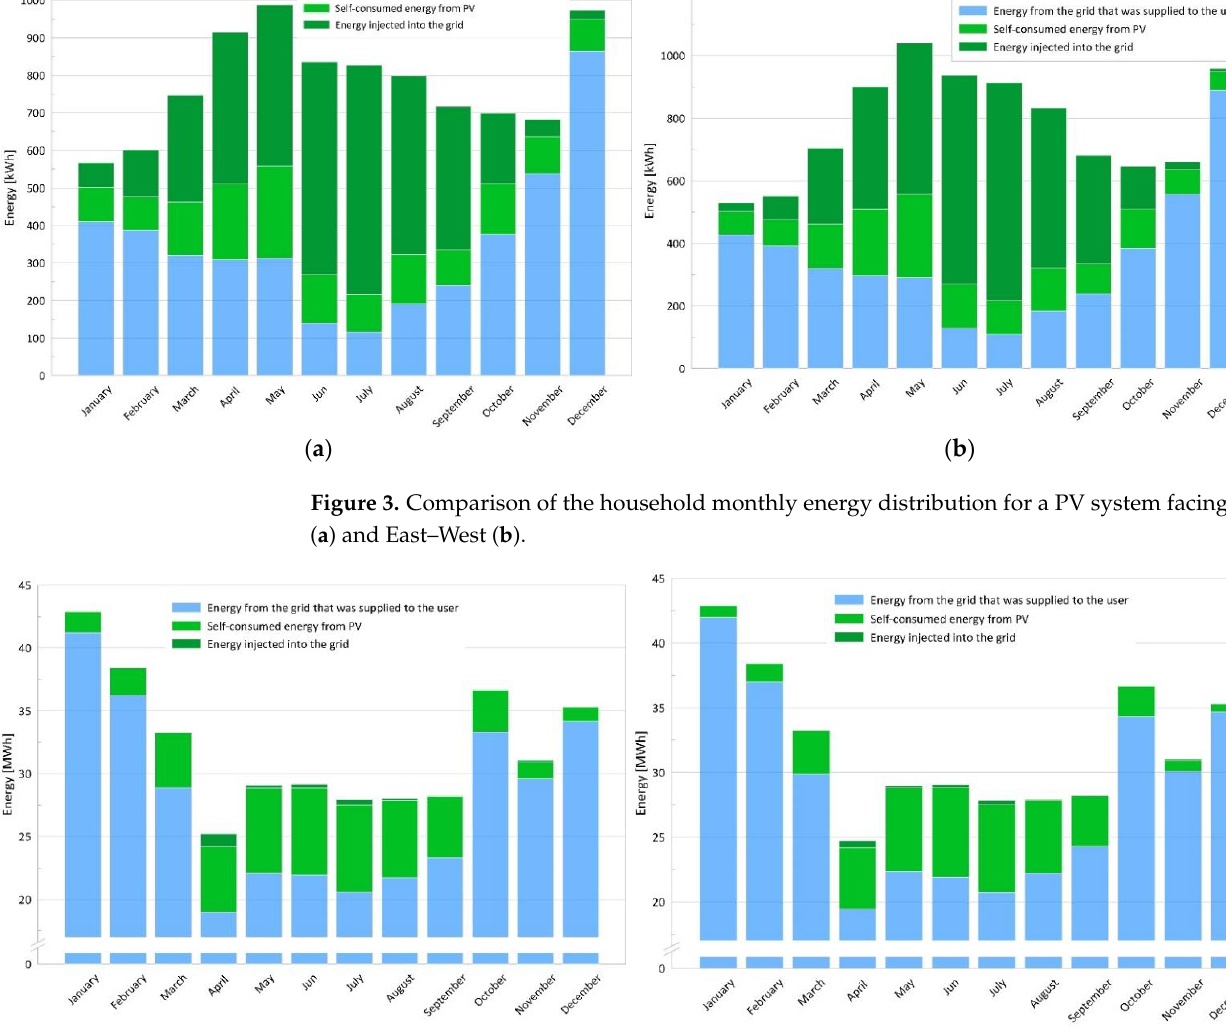
Table 3. Main PV system working parameters extracted from simulations performed in PVSYST.